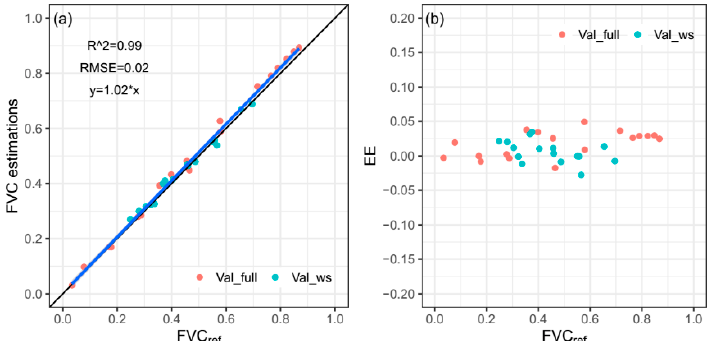
Figure 10. FVC estimation results ( a ) obtained using fixed-threshold method on a*_I color feature of validation image group (Val_full and Val_ws), and corresponding EEs ( b ).